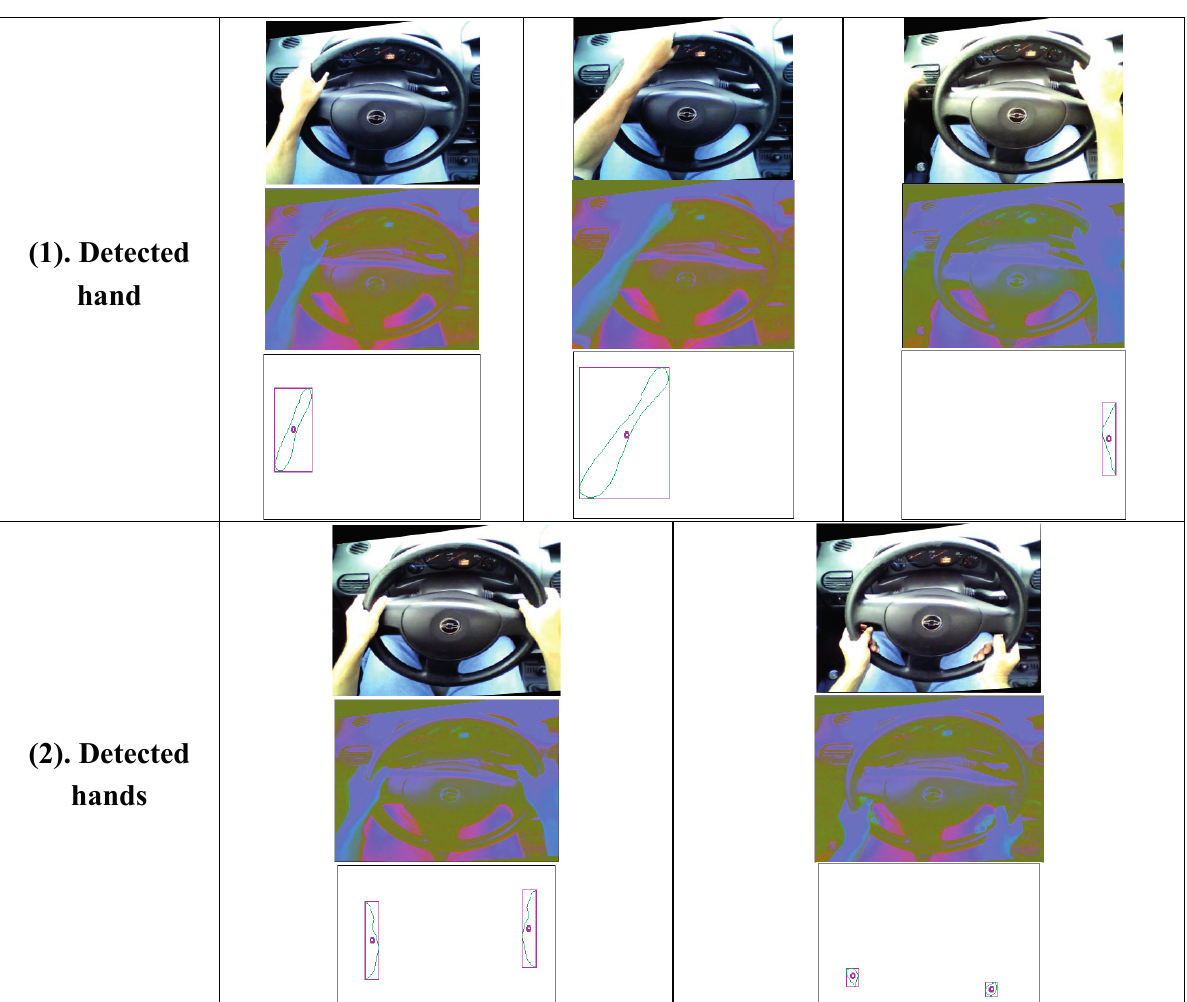
Figure 17. Hands